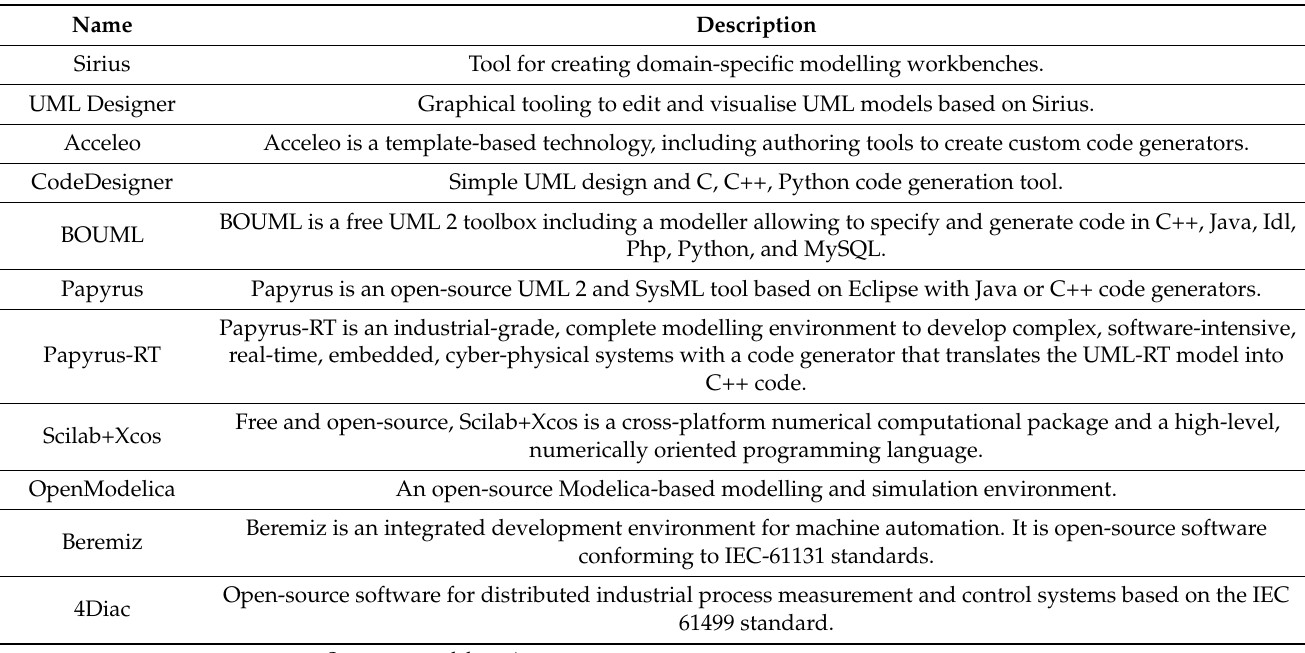
Table 7. Control system modelling